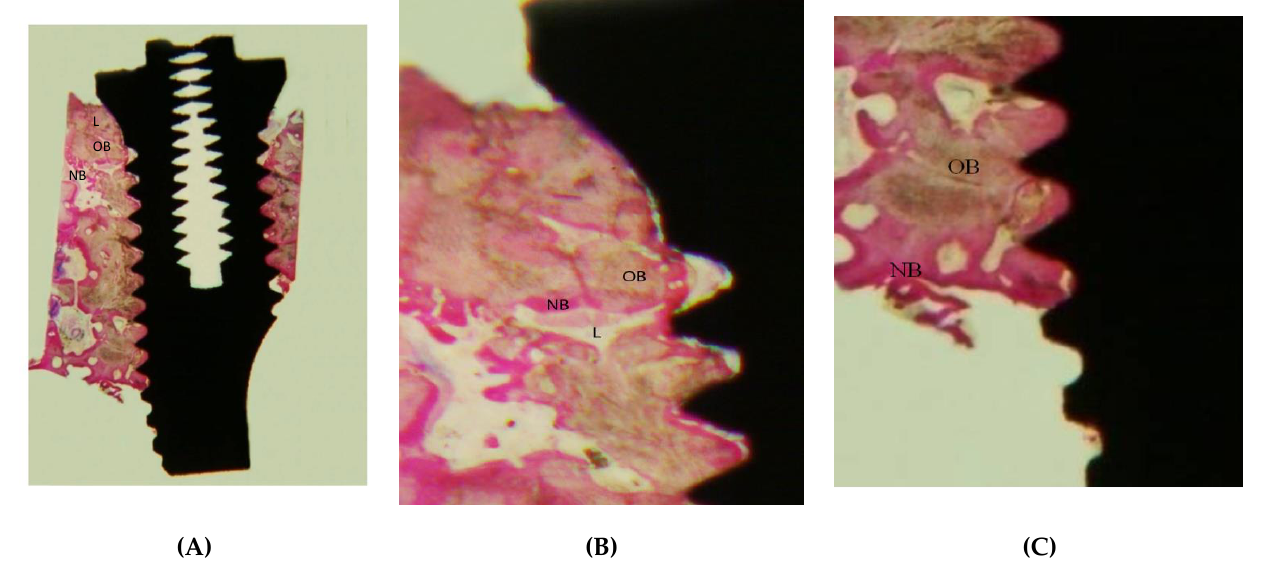
Figure 5. ( A ) In the coronal segment of the implant the old bone (OB) is in contact with the trabeculae of new bone (NB), interspersed with bony lacunae (L). The detachment of the first three threads of the implant from the bone seems to be due to a histological preparation artifact (basic fuchsin, 15× magnification). ( B ) Direct contact of the old bone (OB) and new bone (NB) with the implant thread in the apical portion of the implant (basic fuchsin, 15× magnification), L = lacunae. ( C ) Histological view of the removed implant. Only the middle and coronal segments of the implant are in contact with bone (1.5× magnification).